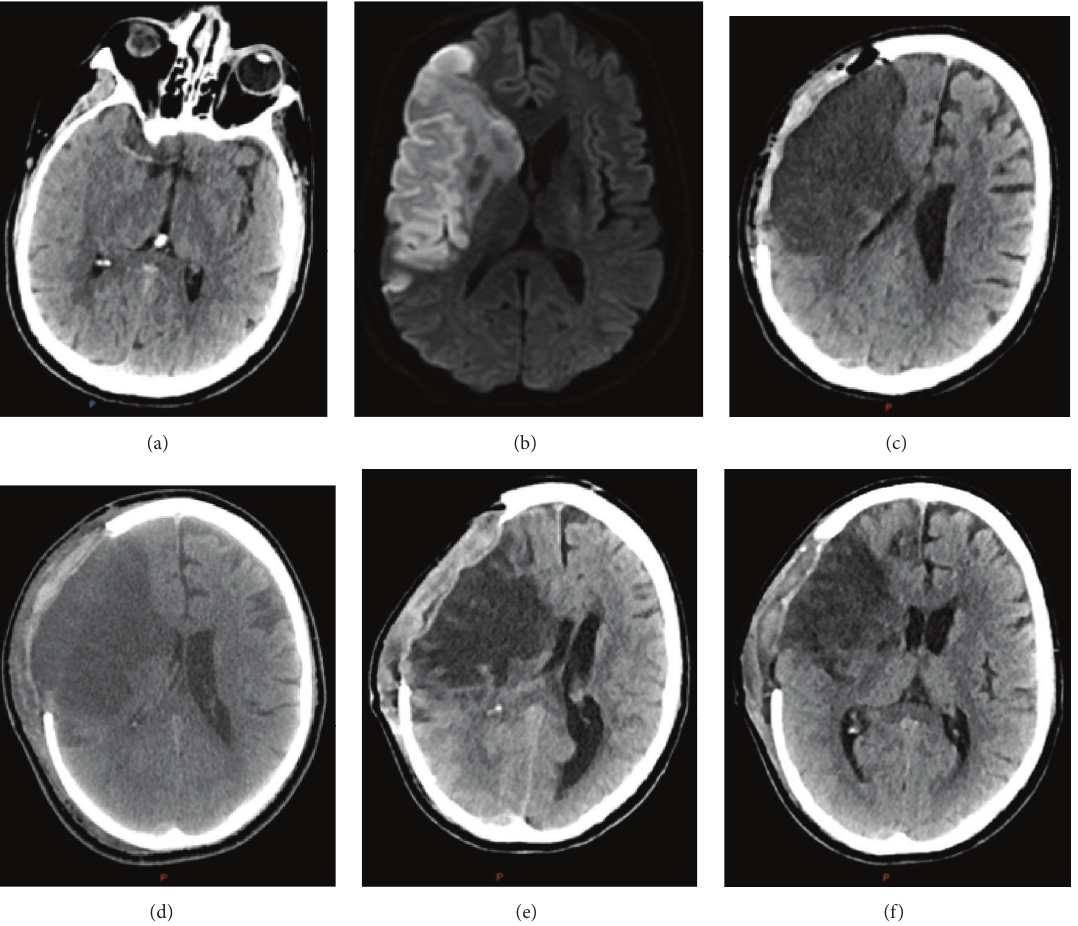
Figure 1: (a) Original CT angiogram revealing a dense right MCA sign. (b) Initial MRI with diffusion weighted sequencing. (c) Postcrani- ectomy CT. (d) Postop day #4 s/p hemicraniectomy. (e) Sunken flap CT, POD #8. (f) Head CT postop day